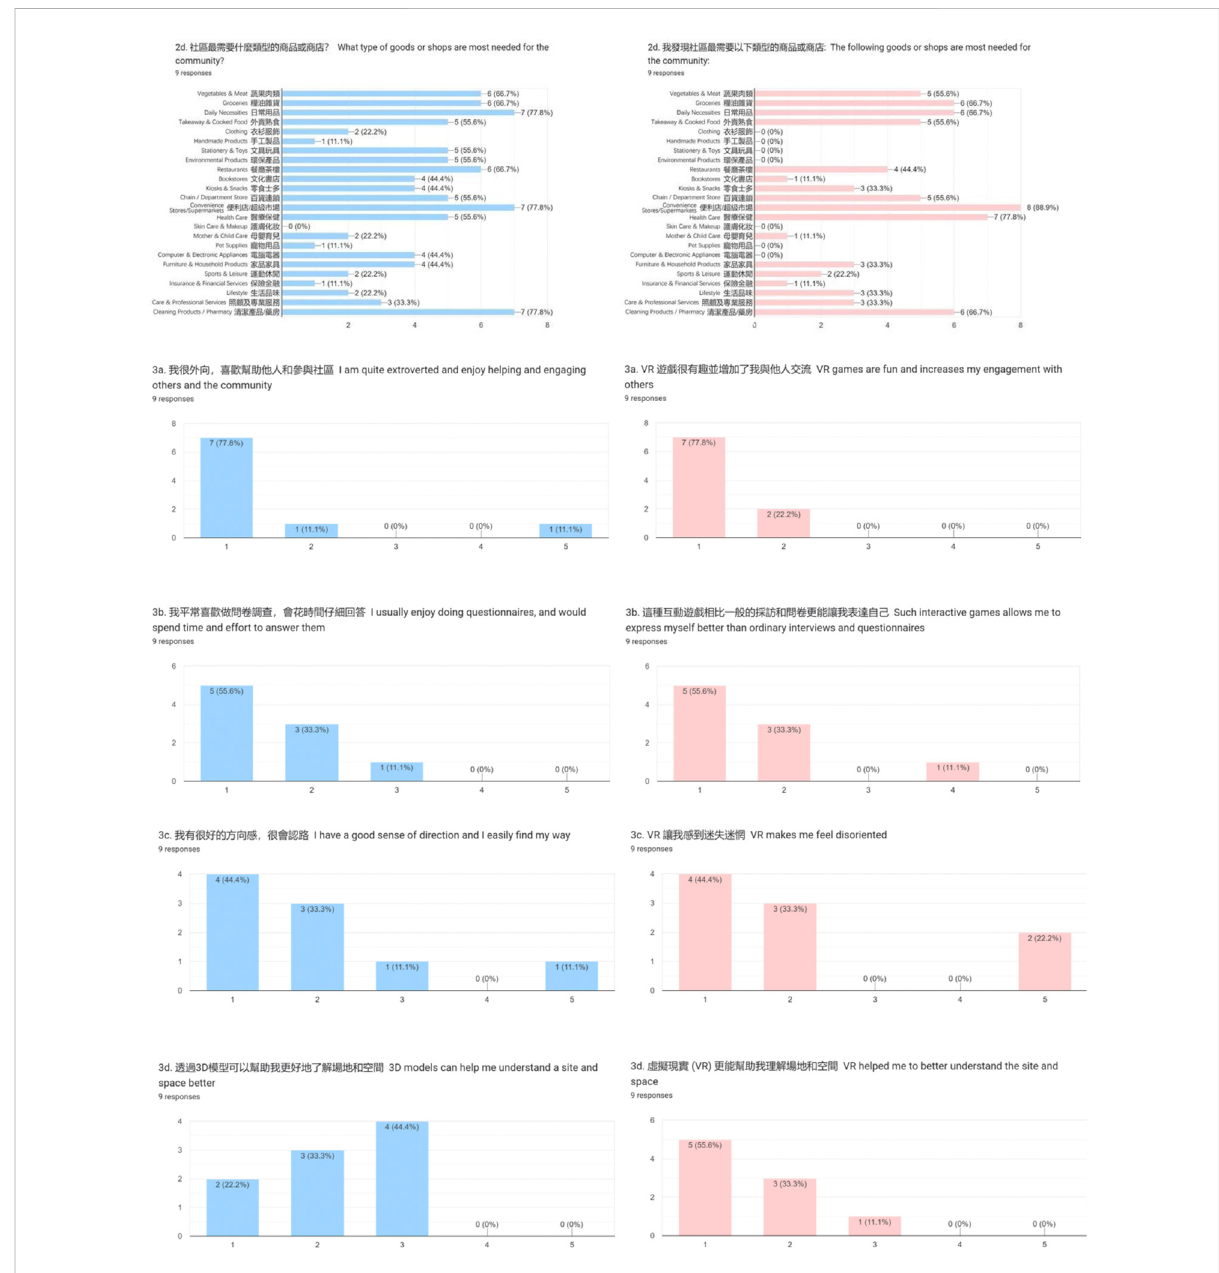
FIGURE A2 Pre-gameplay (blue) and post-gameplay (pink)